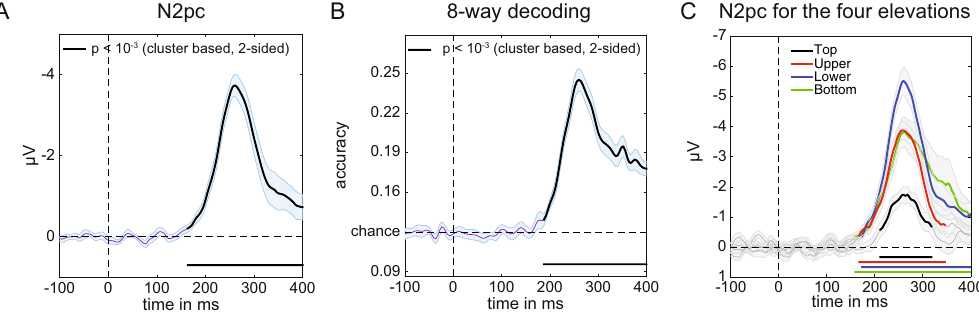
Figure 6. Decoding accuracy in Experiment 2. ( A ) 8-way classification accuracy of target position (chance = 0.125). The black line reflects significance at p < 10 − 3 (cluster based permutation test), shaded area is + / − s.e.m. Peak at 264 ms. Note again the similarity in temporal evolution with the N2pc (Fig. 3) and decoding accuracies of Experiment 1 (Fig. 4), although plausibly peaking slightly later because of the increase in the number of items on the screen. ( B ) Classsification accuracy per quadrant (chance = 0.5). ( C ) Separate N2pc components were computed for left versus right target objects at each of the four vertical elevations, indicated by color. Colored sections indicate p < 10 − 3 (cluster based permutation test).